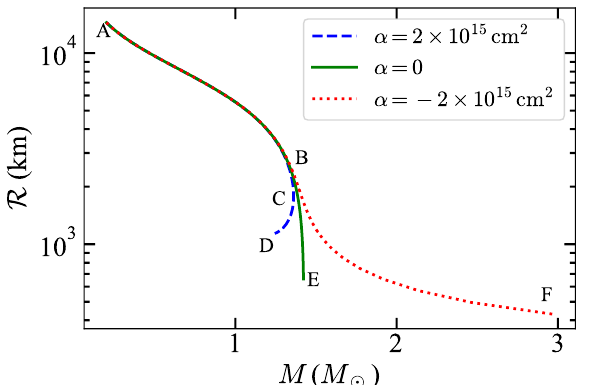
Figure 1. Mass–radius relation of f ( R ) gravity inspired WDs. The GR case is represented by α =